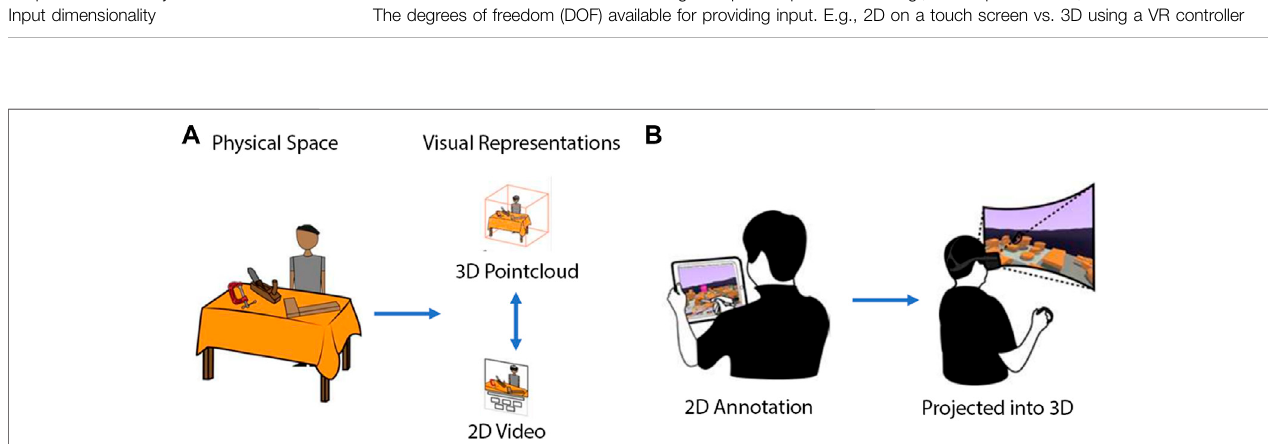
TABLE 1 | Key terms and de fi nitions used throughout this paper. Term De fi nition Extended collaborative space (xspace) Interactive mixed-dimensional